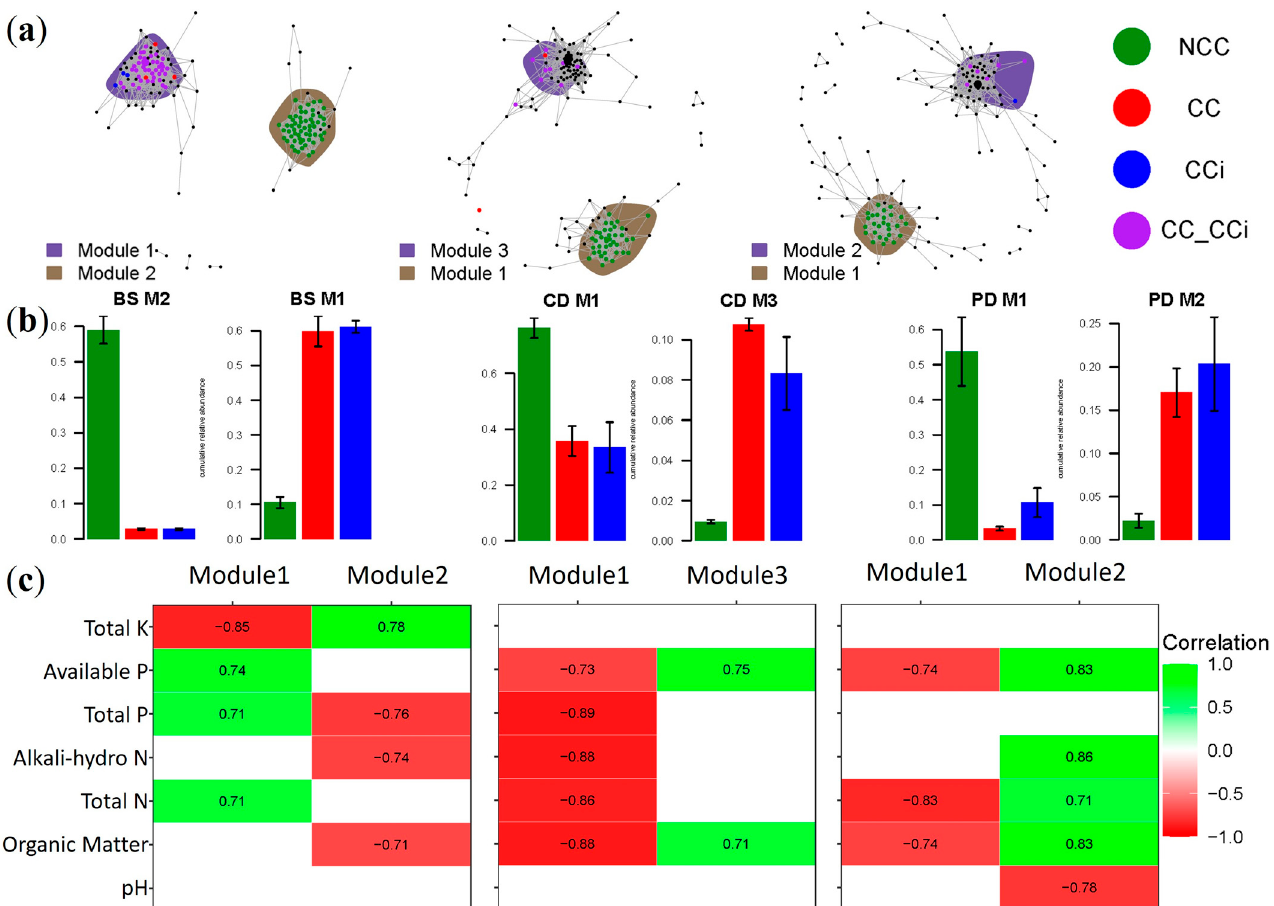
Figure 4. Co-occurrence patterns of cropping-sensitive OTUs. ( a ) Co-occurrence networks visualizing significant correlations ( ρ > 0.7, p < 0.05; indicated with gray lines) between OTUs in soil. OTUs are colored by their association with the different cropping systems (black OTUs are insensitive to cropping practices). Shaded areas represent the network modules containing csOTUs; ( b ) Cumulative relative abundance of the cropping sensitive modules in NCC, CC, and CCi soil networks ( y -axis reported cumulative relative abundance). NCC (forest green), CC (red), CCi (blue); ( c ) Spearman’s correlations between modules and environmental variables in NCC, CC, and CCi. Only significant correlations ( p < 0.05) are shown. Table 2. Properties of fungal co-occurrence networks.